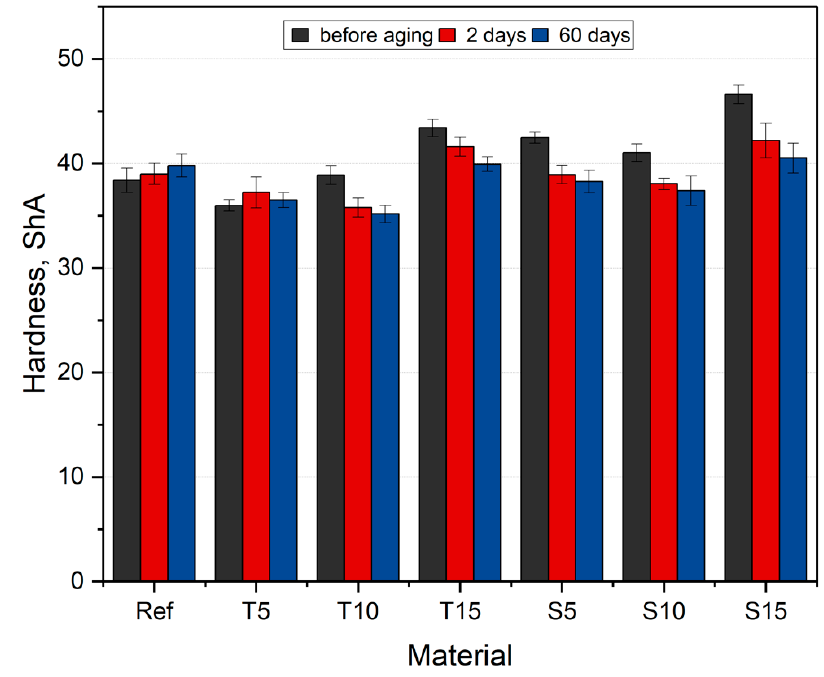
Figure 15. Hardness results.